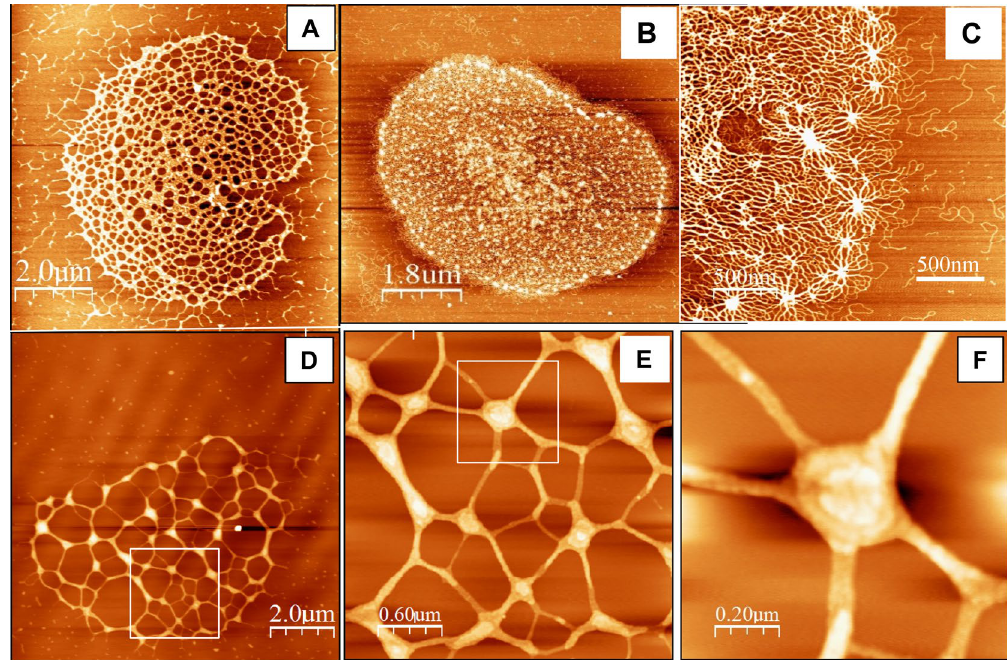
Figure 4. kDNA condensation intermediates consist of interconnected local condensation foci (LCF). Isolation and purification of uncondensed kDNA networks and their analyses by AFM were performed as described in the “Methods”. (A–C) Uncondensed kDNA networks (bars = 2.0 µm in (A) ; 1.8 µm in (B) ; and 500 nm in (C) ). (D) A kDNA condensation intermediate network resulting from the interaction of an uncondensed kDNA network (5.4 pM) with 1.5 nM KAP3. (E) A higher resolution scan of the area defined by a square in the partially condensed network in (D) . (F) A higher resolution scan of the condensation focus marked by the square in (E) (bars in (D–F) = 2.0, 0.6 and 0.2 µm,